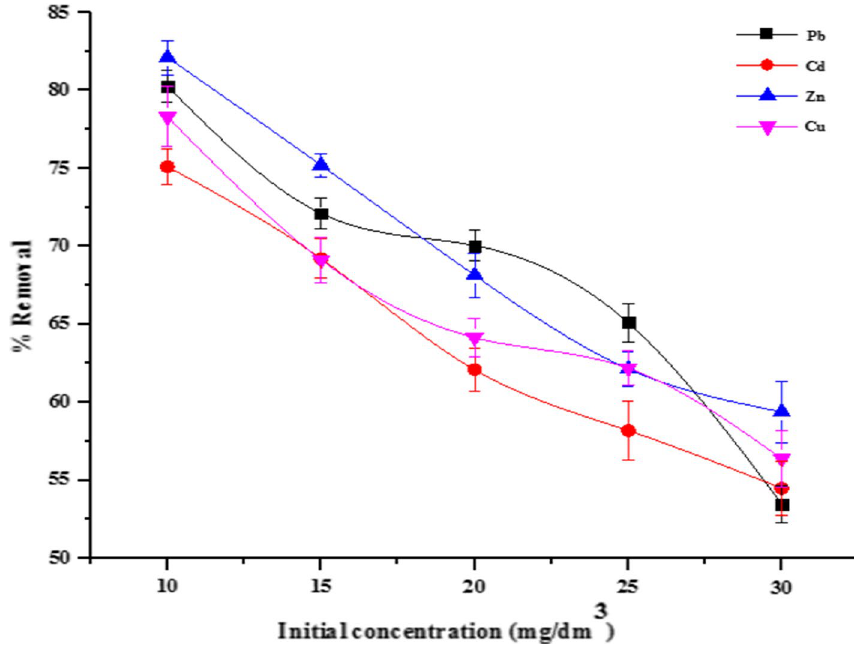
Fig. 7 Effect of initial metal